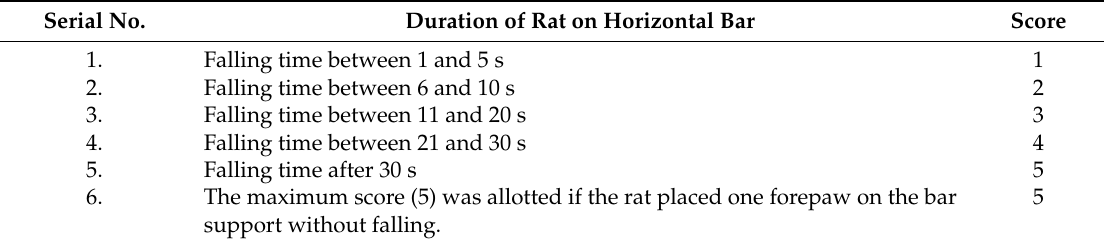
Table 1. Scoring procedures in the horizontal bar